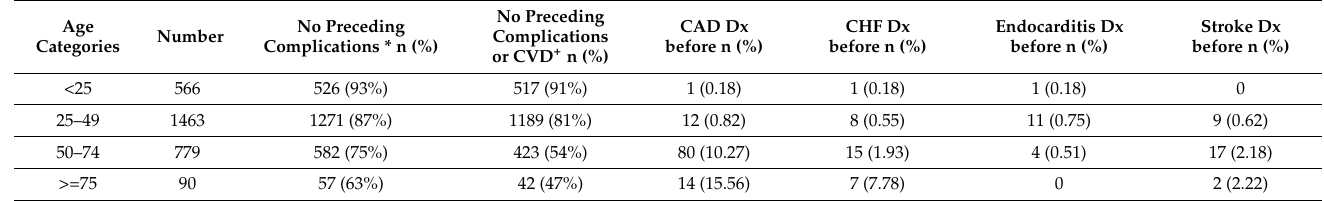
Table 2. Frequency of BAV complications or CV disease before diagnosis by age.